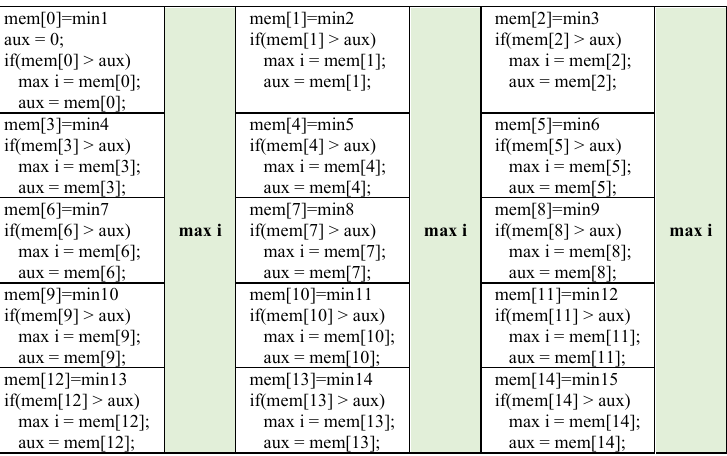
Figure 7. Membership function (MF) compositions based on the maximum (max) and minimum (min) operations results.